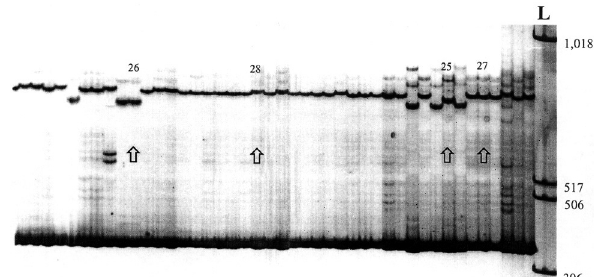
Figure 4 - SSCP profiles of a mtDNA fragment (16S) of Hoplias malabaricus from the Rio Doce basin. Arrows and numbers indicate se- quenced haplotypes.